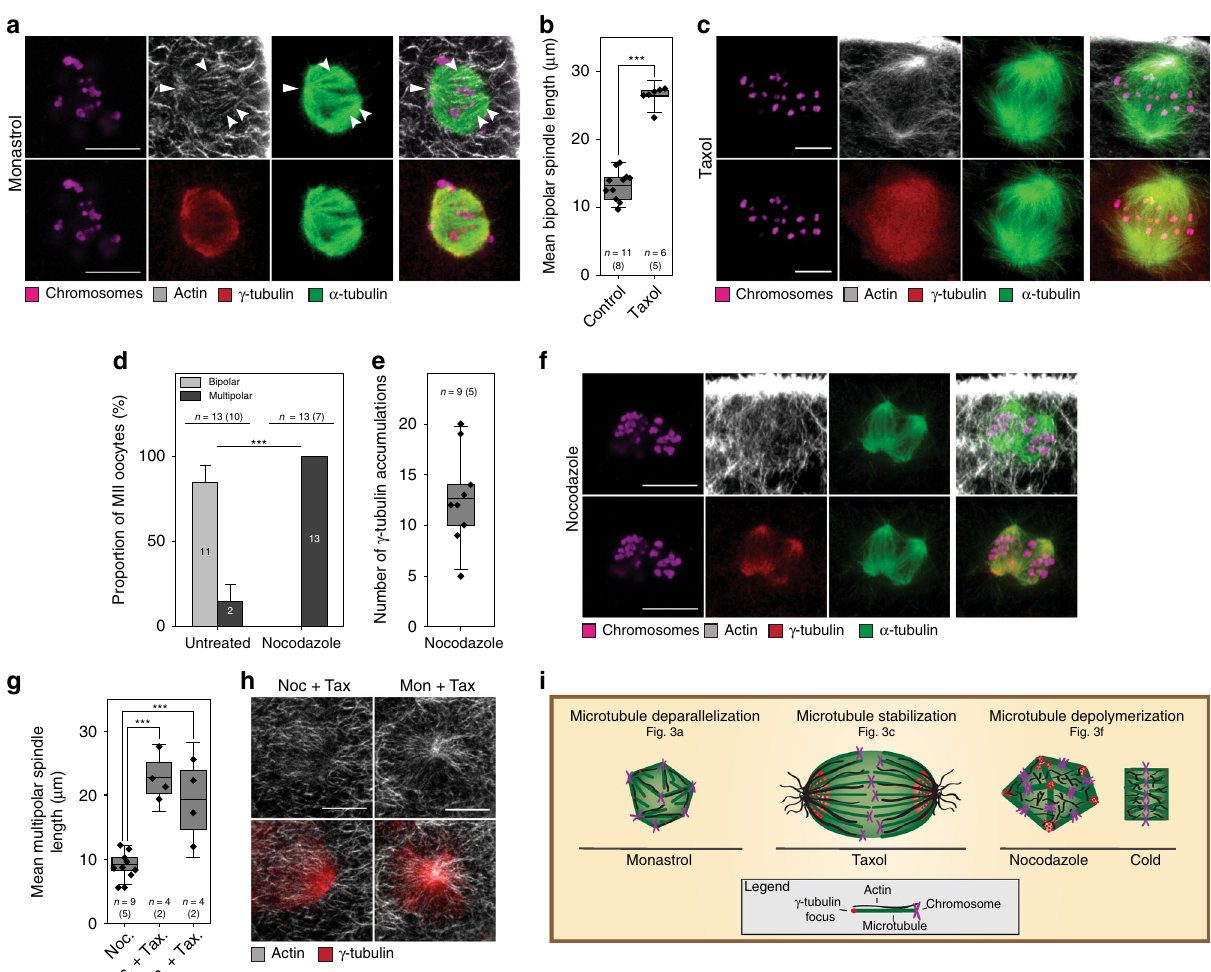
Fig. 3 Disruption of microtubules promotes multipolar spindle formation and causes spindle actin reorganization. a Representative z -projections of monastrol-treated MII oocytes showing actin (phalloidin) and microtubules ( α -tubulin) as indicated by arrowheads (upper panel); γ -tubulin and microtubule colocalization (lower panel); z = 3 sections. Representative of n = 4 oocytes. b Mean length of bipolar spindles in untreated and taxol-treated MII oocytes. c Localization of chromosomes (Hoechst), actin (phalloidin), α -tubulin (upper panel), and γ -tubulin (lower panel) in taxol-treated MII oocytes; z = 27 sections. Representative of n = 6 oocytes. d Frequency of bipolar and multipolar spindles in untreated and nocodazole-treated MII oocytes. e Number of distinct γ -tubulin accumulations in nocodazole-treated MII oocytes. f Immuno fl uorescence images showing chromosomes (Hoechst), actin (phalloidin), and microtubules ( α -tubulin) at the multipolar spindles of oocytes treated with nocodazole (upper panel); γ -tubulin at multipoles (lower panel); z = 10 sections. Representative of n = 5 (upper panel) and n = 4 (lower panel) oocytes. g Mean distance between spindle multipoles in oocytes treated with nocodazole alone and oocytes consecutively treated with nocodazole and taxol or monastrol and taxol. h Immuno fl uorescence images showing actin (phalloidin) and γ -tubulin at the poles of multipolar spindles in MII oocytes consecutively treated with nocodazole and taxol or monastrol and taxol; z = 5 and 8 sections. Representative of n = 4 and 4 oocytes. i Schematic illustration of chromosomes, microtubules, and actin at the spindle of MII oocytes upon treatment with different cytoskeletal drugs or exposure to cold. Scale bars, 10 μ m. n = total number of oocytes. The number of donors is speci fi ed within parentheses. Center lines represent mean values; boxes illustrate 25th and 75th percentiles. Error bars represent standard deviation ( b , e , g ) and standard error of the mean ( d ). Signi fi cance was tested using Fisher ’ s exact test ( d ) and the two-tailed two sample t -test ( b , g ). Asterisks denote p -values: *** < 0.001. Source data are provided as a Source Data fi